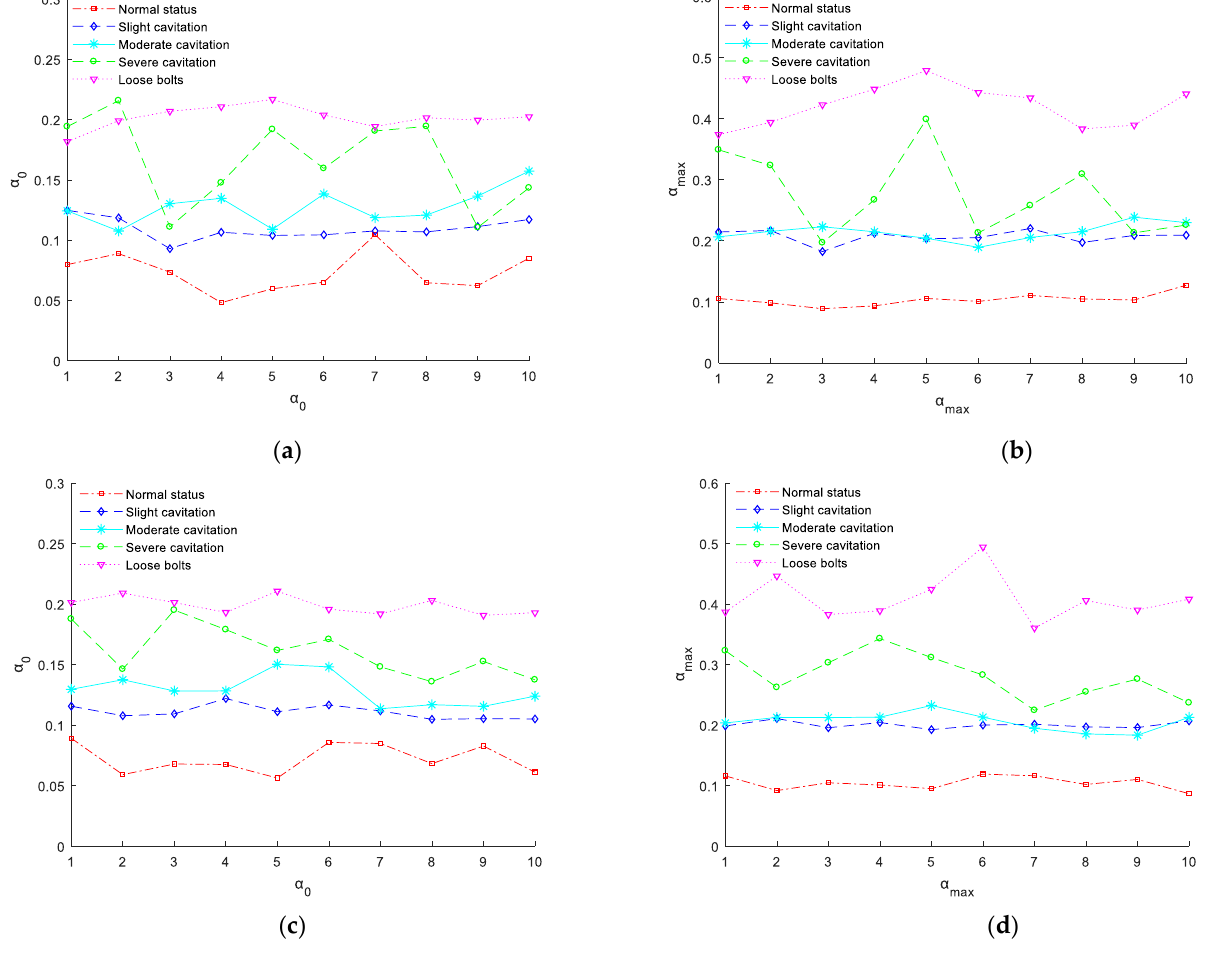
Figure 8. Classification and comparison of centrifugal pump vibration signals by α 0 and α max of different methods: ( a ) α 0 from MFDFA, ( b ) α max from MFDFA, ( c ) α 0 from EMD-LS-MFDFA, ( d ) α max from EMD-LS-MFDFA.